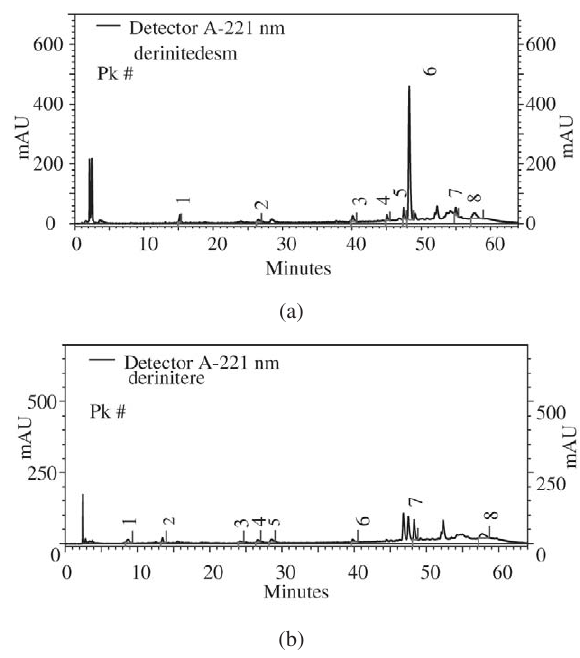
Figure 3. a) Chromatograms of acid; b) buffer solutions after pH